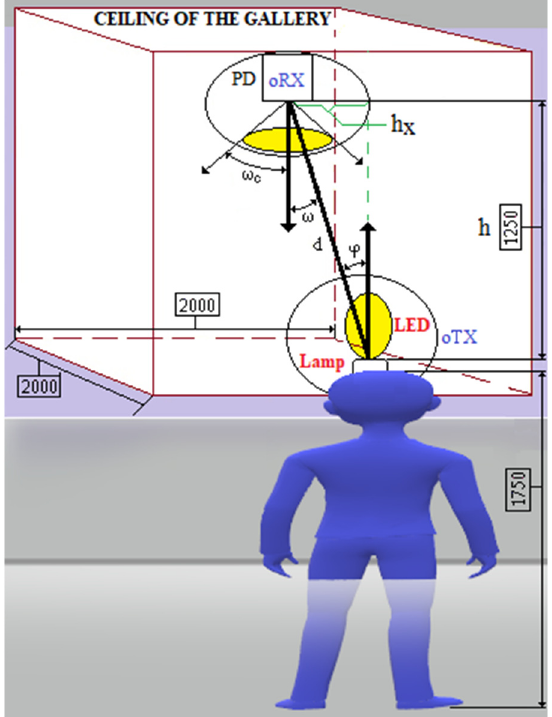
Figure 14. The VLC setup with LOS topology on the main gallery underground.